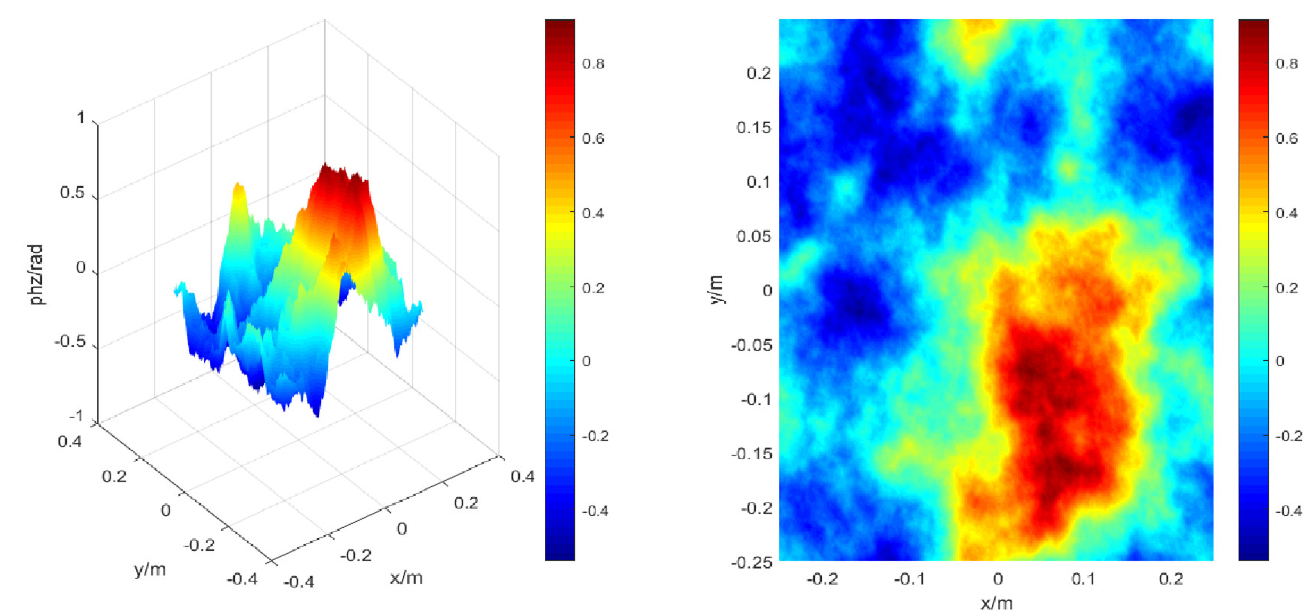
Figure 8. The three-dimensional ( left ) and two-dimensional ( right ) schematic diagrams of the numerically simulated phase distribution in the turbulent atmosphere after the third harmonic compensation under the same conditions.